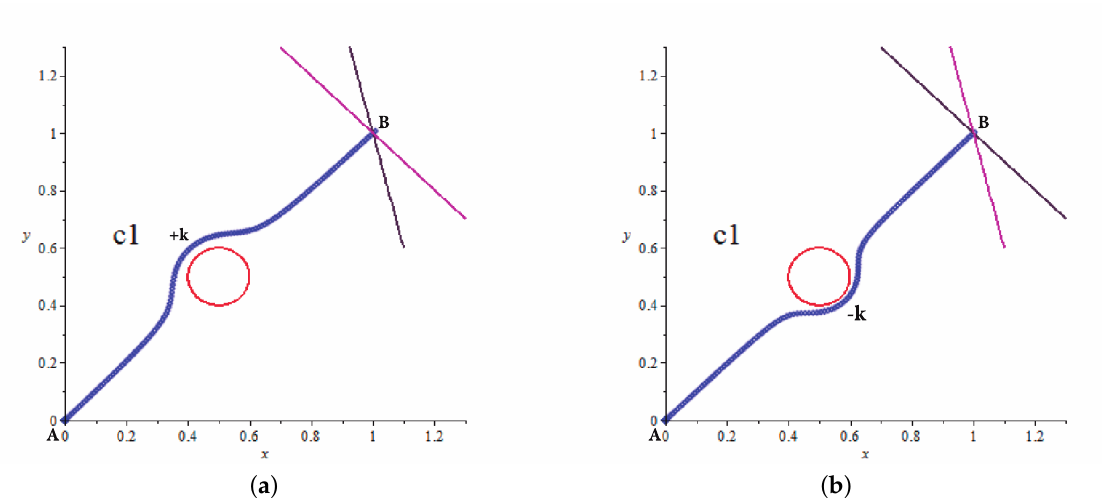
Figure 6. Relationship between k sign value and the resulting path. ( a ) Obstacle avoidance due to a positive k value; ( b ) Obstacle avoidance due to a negative k